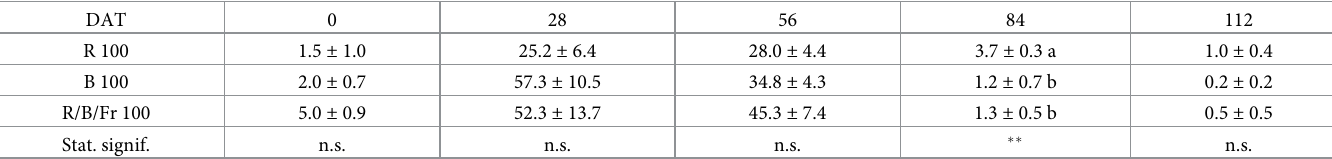
Table 7. Number of sprouts per plant at various days after treatment (DAT) in Taxus baccata exposed to different light quality (R, red; B, blue; Fr, far red) at 100 μ M m-2 s-1. Data are means ± SE (n = 6). DAT